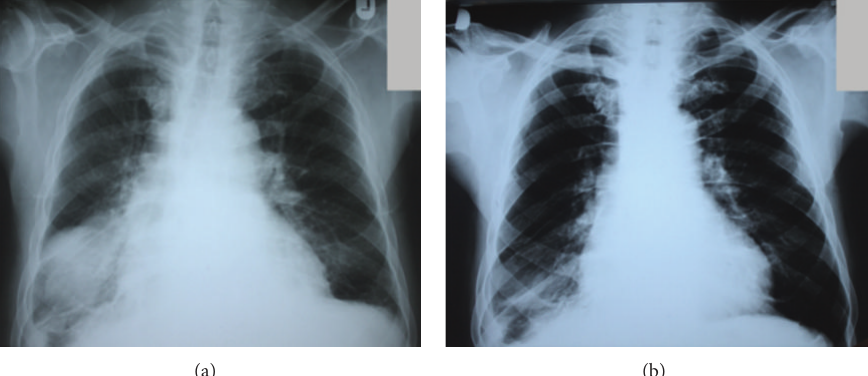
Figure 1: Phantom lung tumor. (a) Chest-X-ray showing homogeneous, sharply demarked opacification (phantom lung tumor) of the right inferior lobe. (b) CXR 3 days later, with absorption of the pseudotumor.